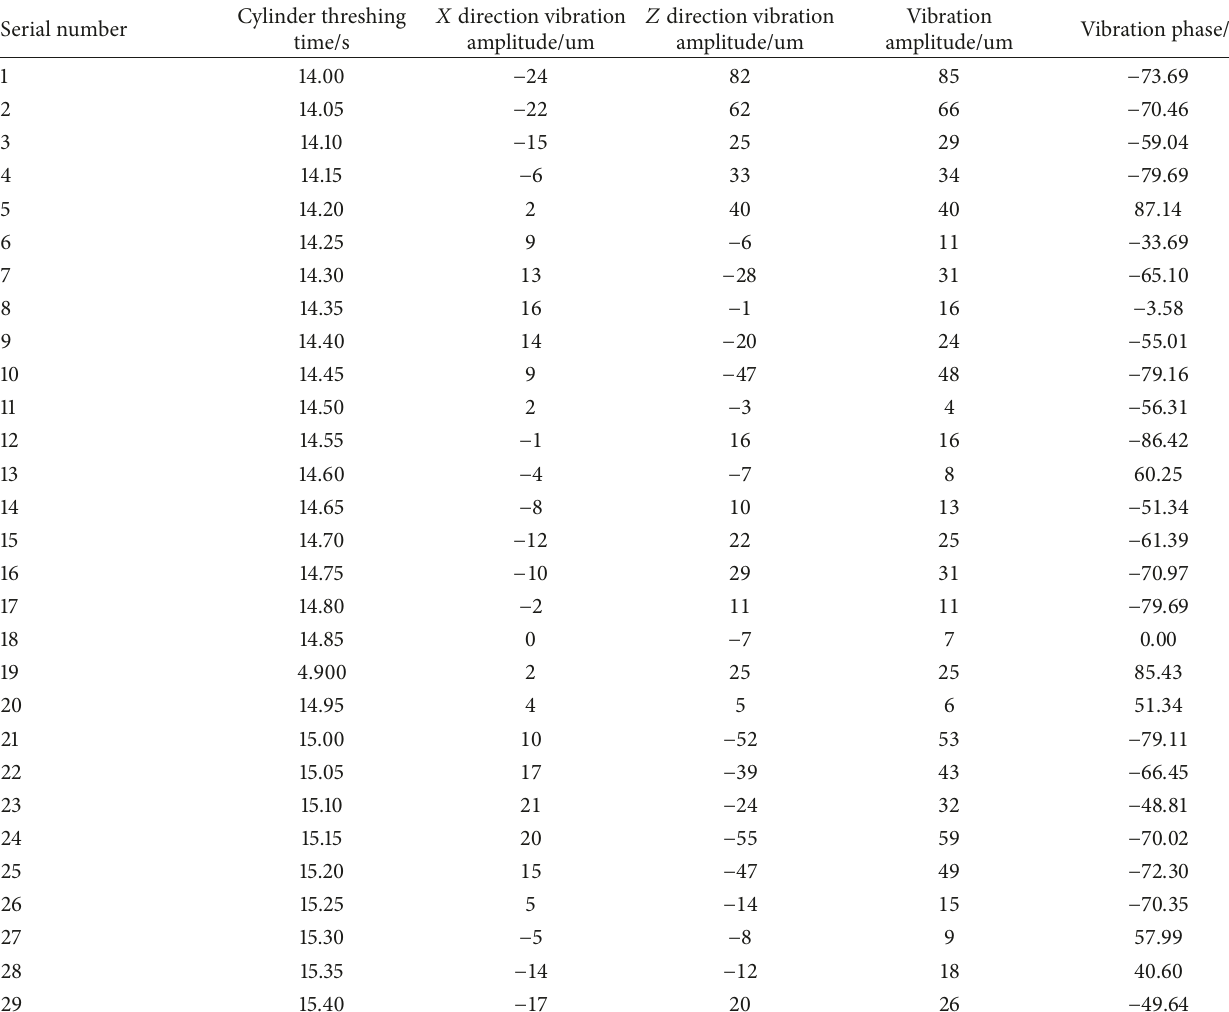
Table 2: 𝑋 and 𝑍 direction vibration values of no-load cylinder rotation.